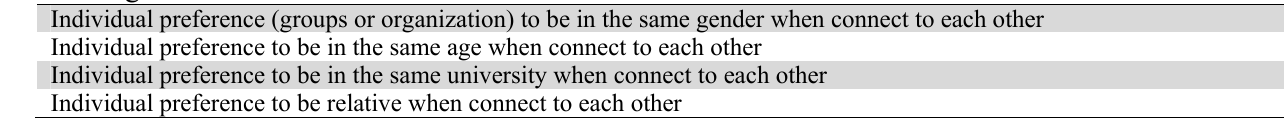
Homogenous indexes of online social networks